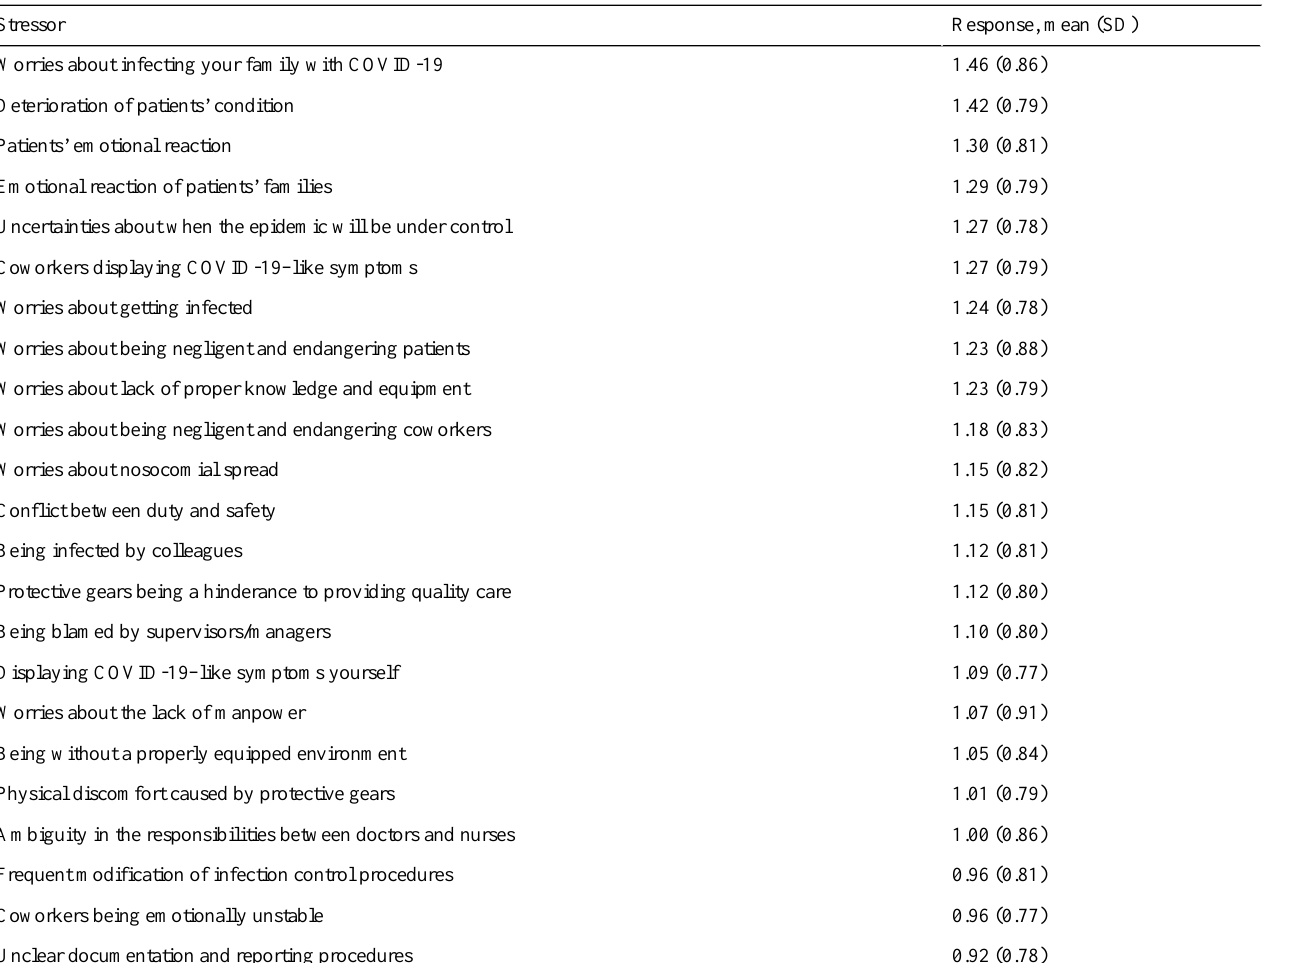
Table 6. Doctors’ and nurses’ responses to the question: when you think about COVID-19 in your life and work, how often did you think or worry about the following things? (0=not at all, 3=very much)